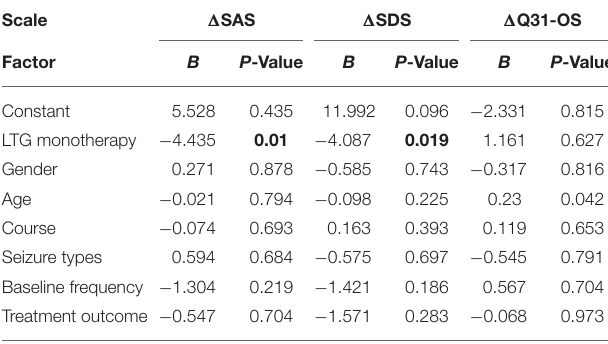
OXC, oxcarbazepine; LTG, lamotrigine; EEG, electroencephalography; 1 , scores change at 6-month follow-up compared with baseline; SAS, self-rating anxiety scale; SDS, self-rating depression scale; OS, overall score; Q31, QOLIE-31. Bold Value indicates the p < 0.05.